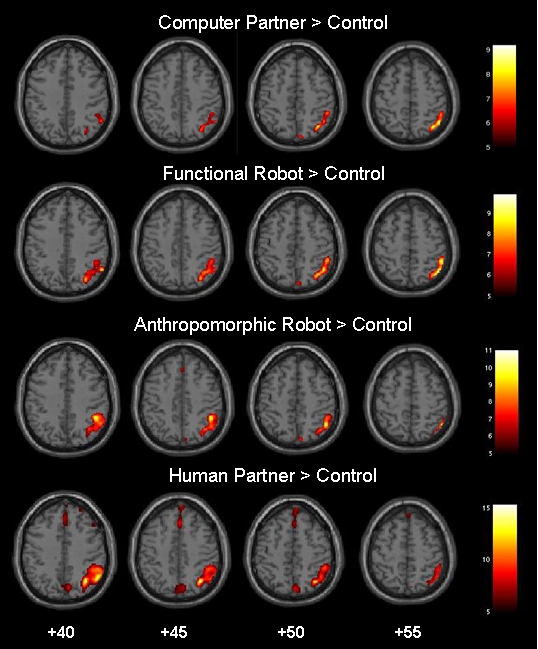
Regions activated more strongly during CP, FR, AR or HP as opposed to control.The activation map (p<0.05, family wise error corrected, minimal cluster size 10 voxels) is shown superimposed onto axial slices (z = +40∶5∶+55) of the T1-weighted SPM-template (http://imaging.mrc-cbu.cam.ac.uk/imaging/DisplaySlices).